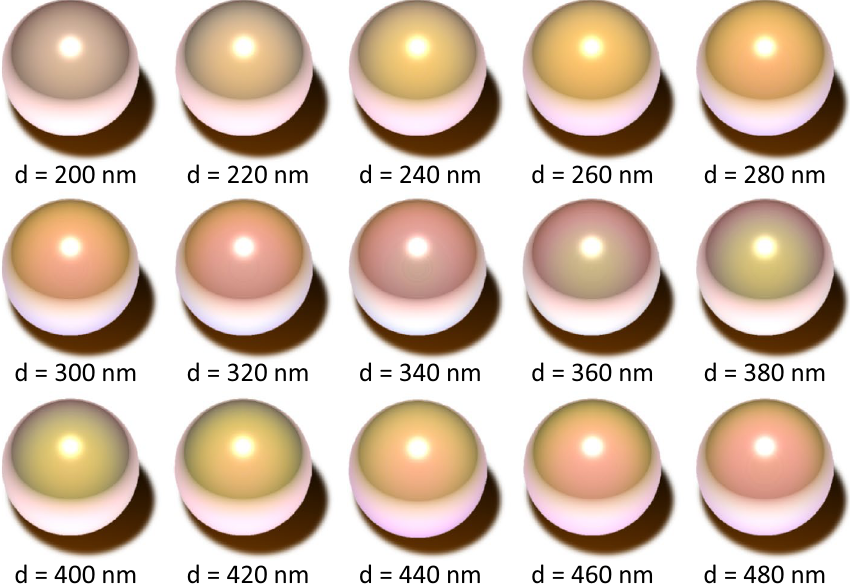
Figure 6. Simulation of appearance of Akoya pearls. The average aragonite crystal layer thickness d gradually changes. The variance σ 2 of all layer thickness distributions is set to be σ 2 = 30